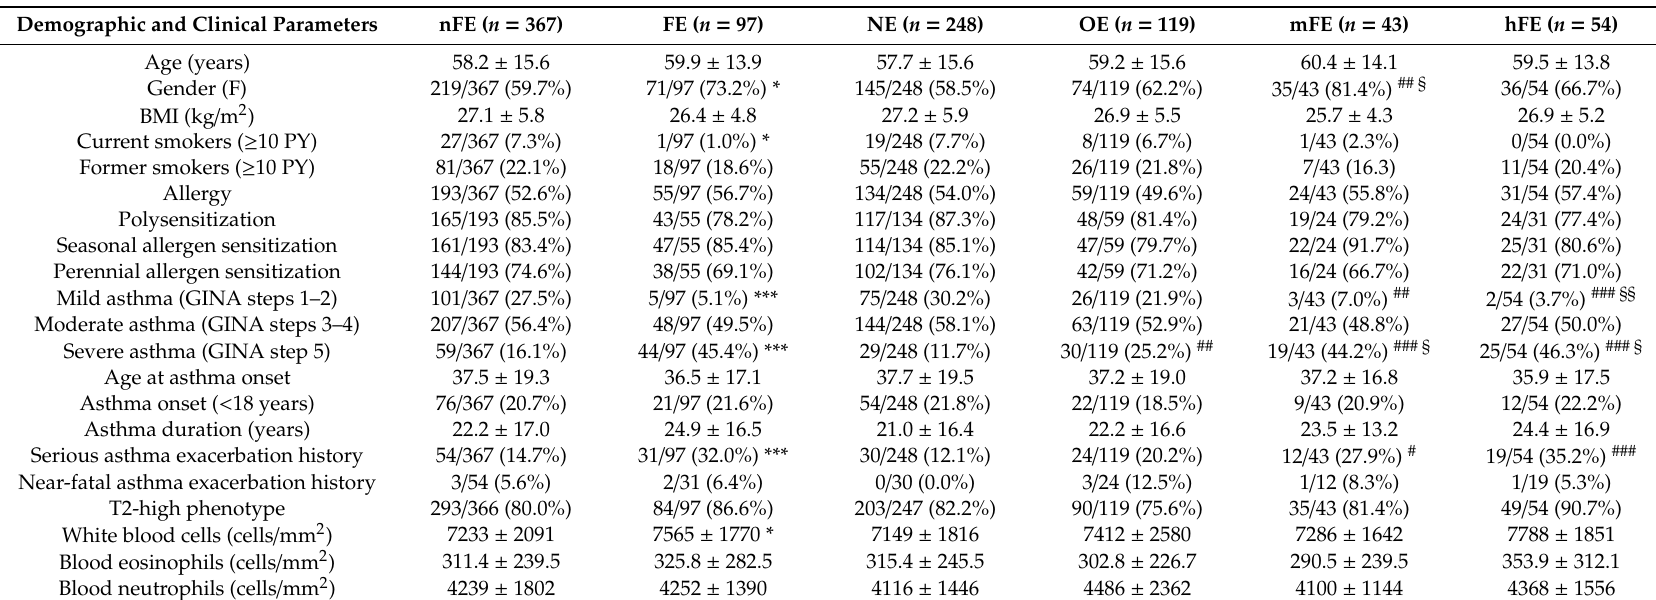
Table 1. Descriptive statistics of the asthmatic